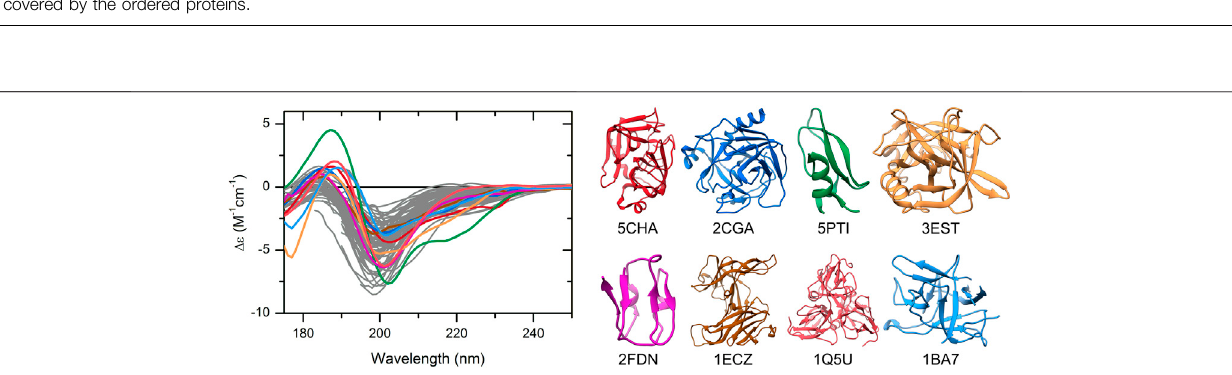
FIGURE2 | CD spectra ofdisordered proteins and some globular proteins with similar spectra. Proteins rich in highly twisted antiparallel β -sheets (colored spectra and corresponding structures) exhibit CD spectra reminiscent of disordered proteins (gray), which makes the distinction between them dif fi cult. Alpha-chymotrypsin (PDB ID: 5CHA), chymotrypsinogen (2CGA), trypsin inhibitor (5PTI), elastase (3EST), ferredoxin (2FDN), ecotin (1ECZ), dUTP pyrophosphatase (1Q5U), and trypsin inhibitor (Kunitz) (1BA7) are